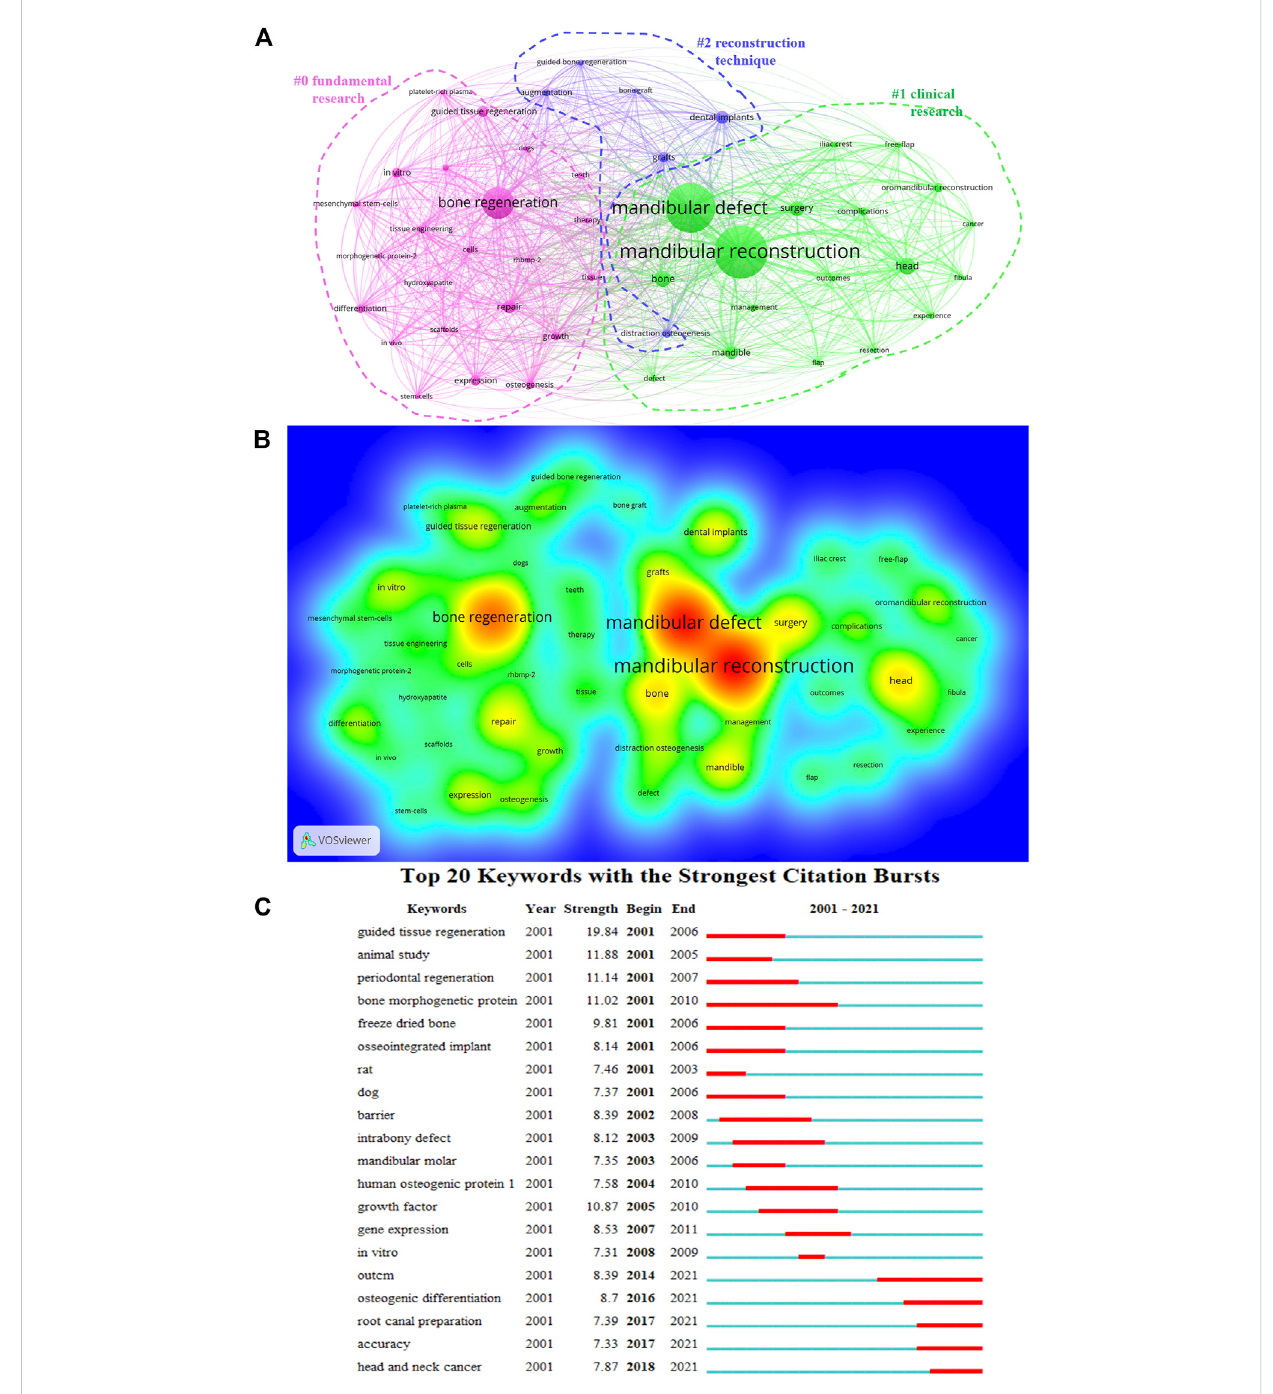
FIGURE 7 Analysis of all keywords of mandibular defect research. (A) VOSviewer visualization map of co-occurring keywords. Of the 11,881 keywords, 50 had at least 80 co-occurrences. (B) The density map of keywords. (C) Top 20 keywords with the strongest citation burst.